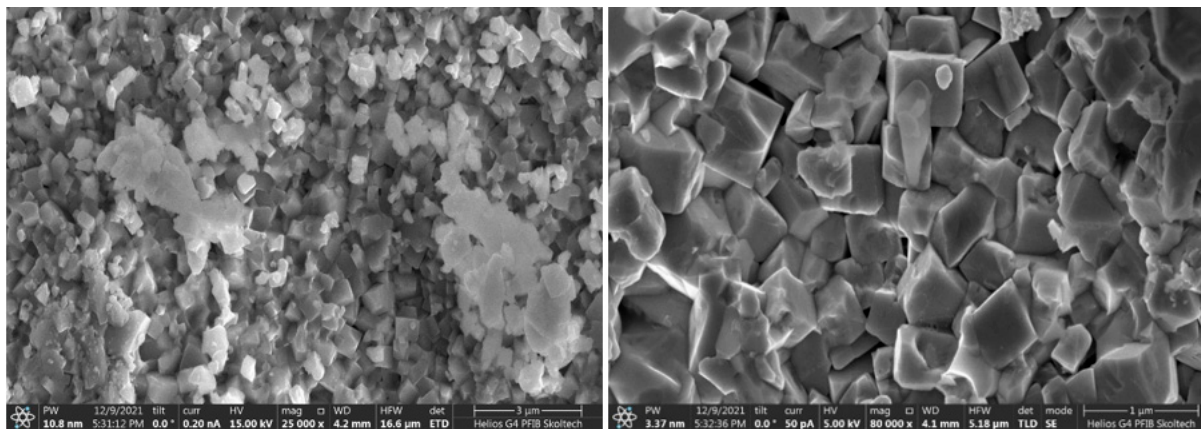
Figure 4. SEM images of LSNF sample prepared by Pechini method.